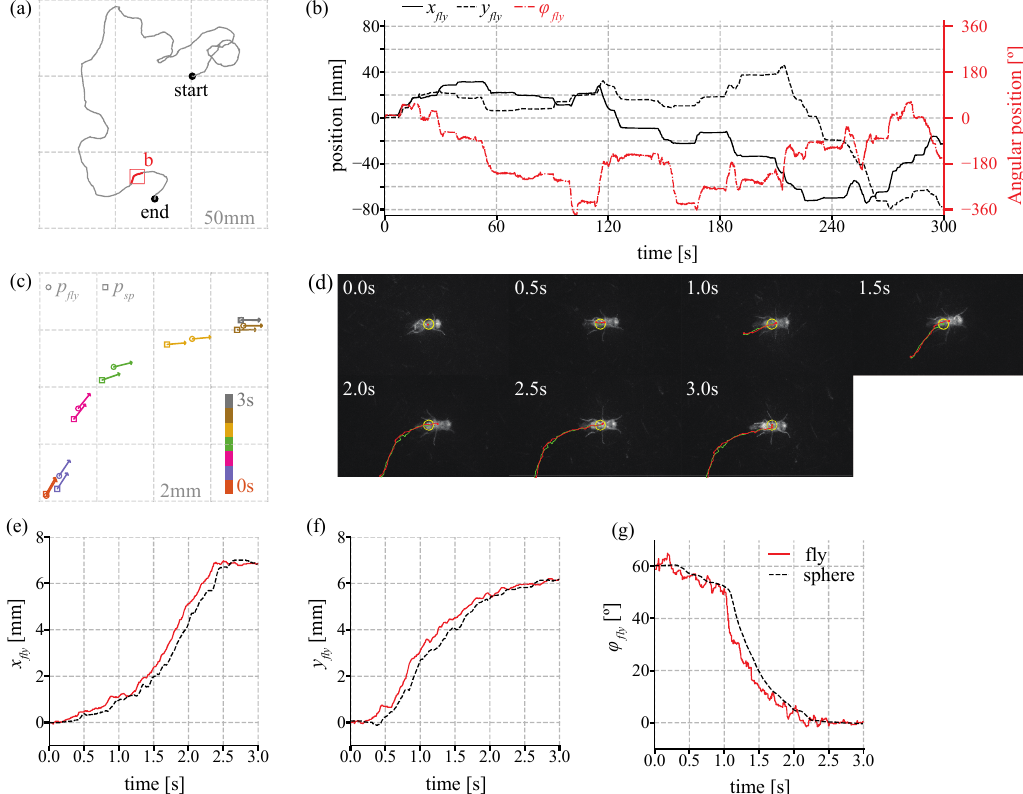
Figure 7. The behavior of the freely walking fruit fly on the TOLC system ( a ) An overall trajectory of a fly for 5 min. The grid size is 50 mm. The total travel distance is 957 mm. ( b ) The coordinates ( x fly , y fly , φ fly ) of the walking fly during in the virtual coordinate. ( c ) The trajectory of p fly and p sp for 3 s which is shown as the red trajectory in ( a ). A circle and square makers show the position of the fly and the sphere in virtual coordinate, respectively. An arrow shows its heading. The data are displayed every 0.5 s. The grid size is 2 mm. ( d ) The NIR behavior images at each time point in ( c ). See Video S2. The red and green are the trajectory of the walking fly and the sphere. ( e – g ) positions p fly and p sp ( e ) x -axis, ( f ) y -axis, and ( g ) heading φ of the walking fly. The solid red and dotted black lines are positions of the walking fly and the TOLC, respectively.